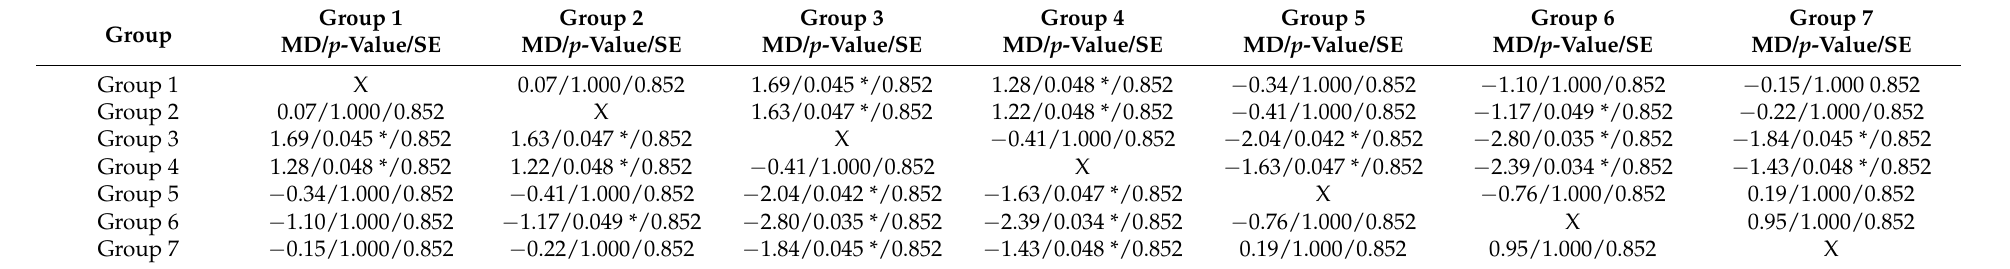
Table 2. Intergroup comparison of mean compressive stress (MPa) at maximum compressive load conducted using the posthoc Bonferroni